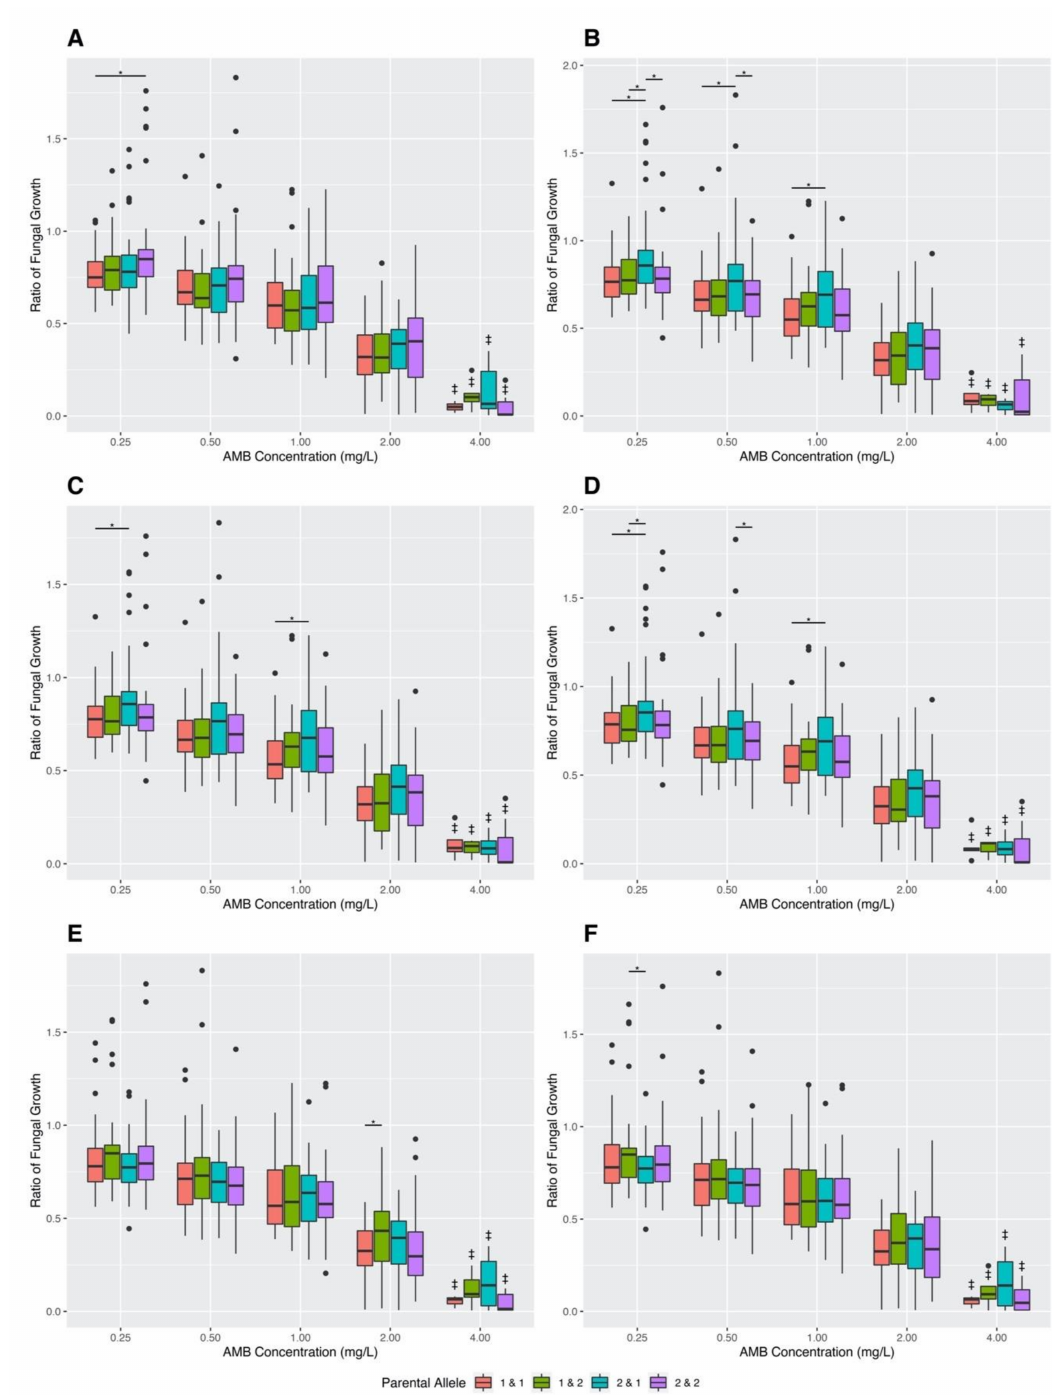
Figure 4. Growths of the 143 progeny strains in varying Amphotericin B concentrations, grouped based on pairwise variant genotype at ( A ) SNP 5 and 1, ( B ) SNP 5 and 2, ( C ) SNP 5 and 3, ( D ) SNP 5 and 4, ( E ) SNP 4 and 1, and ( F ) SNP 2 and 1. Fungal growth was determined by calculating differences in OD 530 at start (0 h) and end of incubation (48 h); this value was divided by fungal growth in the positive control to determine ratio of fungal growth. Parental allele 1 denotes the AFB62-1 genotype and parental allele 2 denotes the CM11 genotype. “*” denotes statistically significant differences (Welch’s t -test p -values < 0.05) and “ ‡ ” indicates bar groups with n ≤